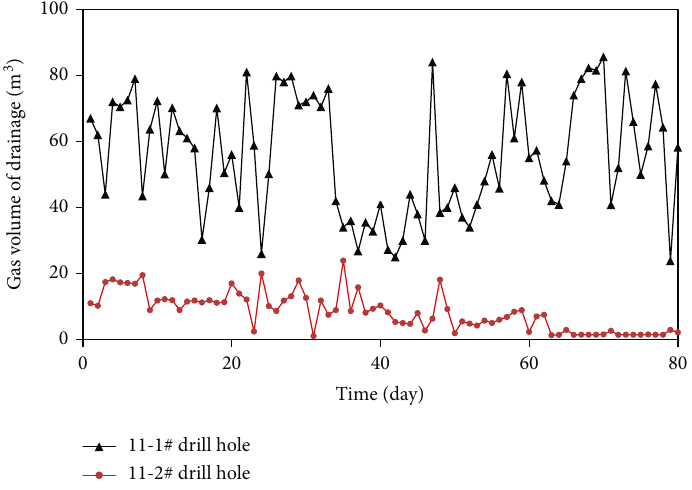
Figure 16: Gas extraction in the borehole group 11#.